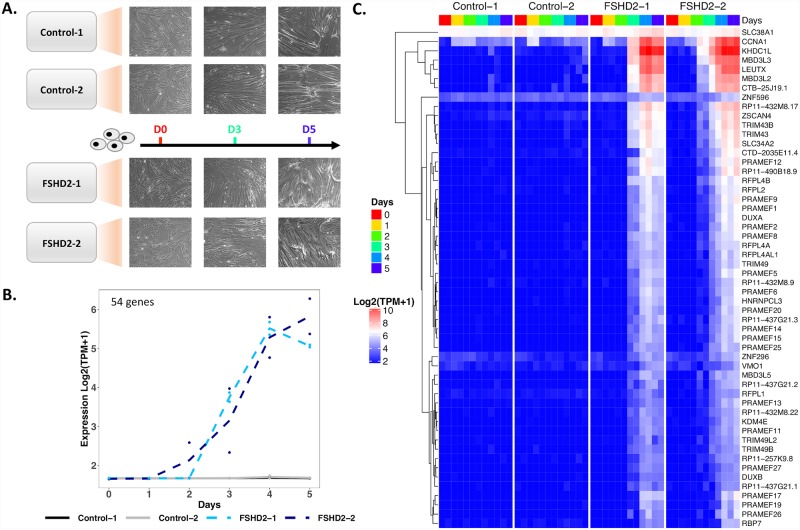
Upregulation of FSHD-induced genes starting at day 2 identified in bulk RNA-seq time-course.(A) Differentiation time-course of control and FSHD2 patient-derived myoblasts to myotubes. Morphology changes are shown for days 0, 3 and 5 of differentiation. (B) Average expression profile of 54 genes upregulated in FSHD2 cells starting at day 2 of differentiation. maSigPro clustered 10,827 genes into three clusters based on their expression patterns during control and FSHD2 differentiation time-course. (C) Hierarchical heatmap of gene expression values of the 54 genes from (B). Expression values in transcripts per million (TPM) are TMM and log normalized. We refer to these 54 genes and DUX4 as “FSHD-induced genes”.